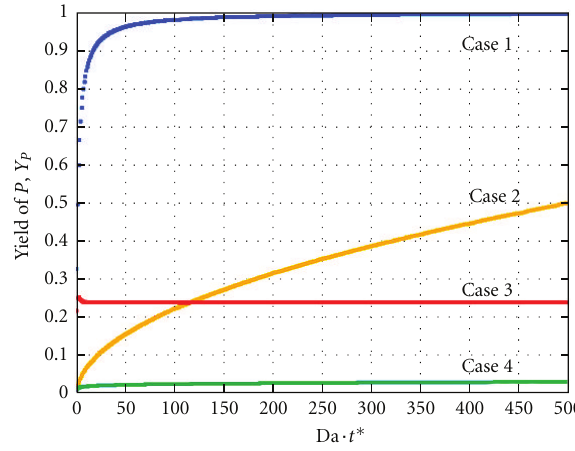
Figure 4: Yield of P versus time for the C-C